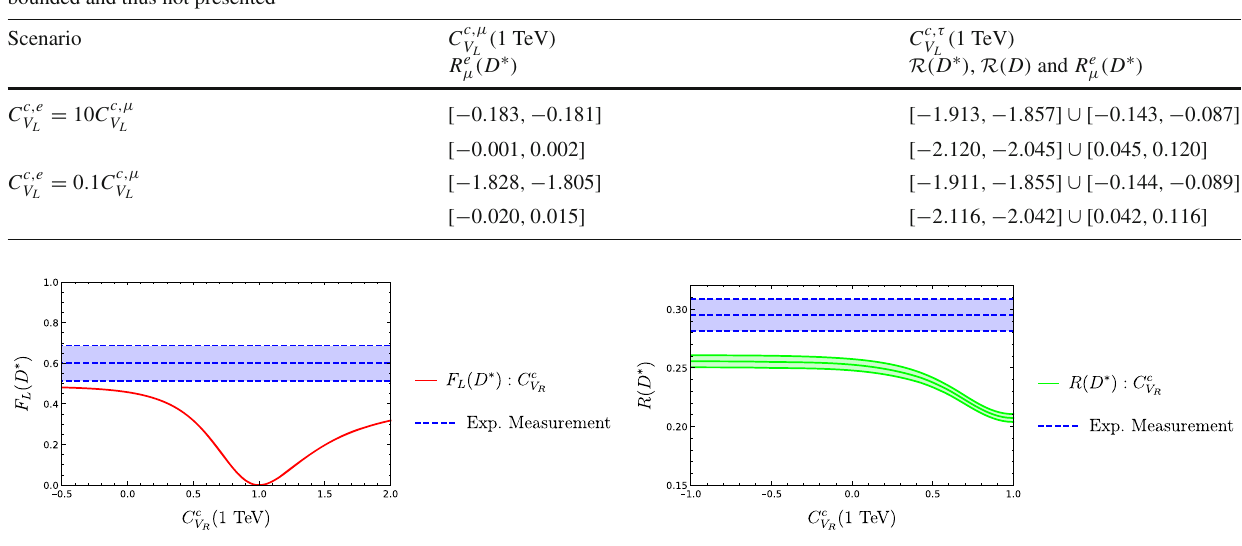
,μ and C c . For the scenario C c , e V L V L